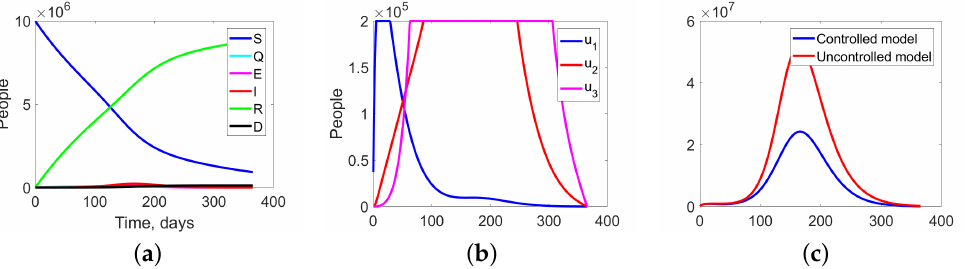
Figure 12. Experiment 2. ( a ) Sum of the fractions of all levels in controlled case; ( b ) the structure of the optimal treatment policies u i ( t ) , i = 1,2,3; ( c ) aggregation costs in uncontrolled and controlled